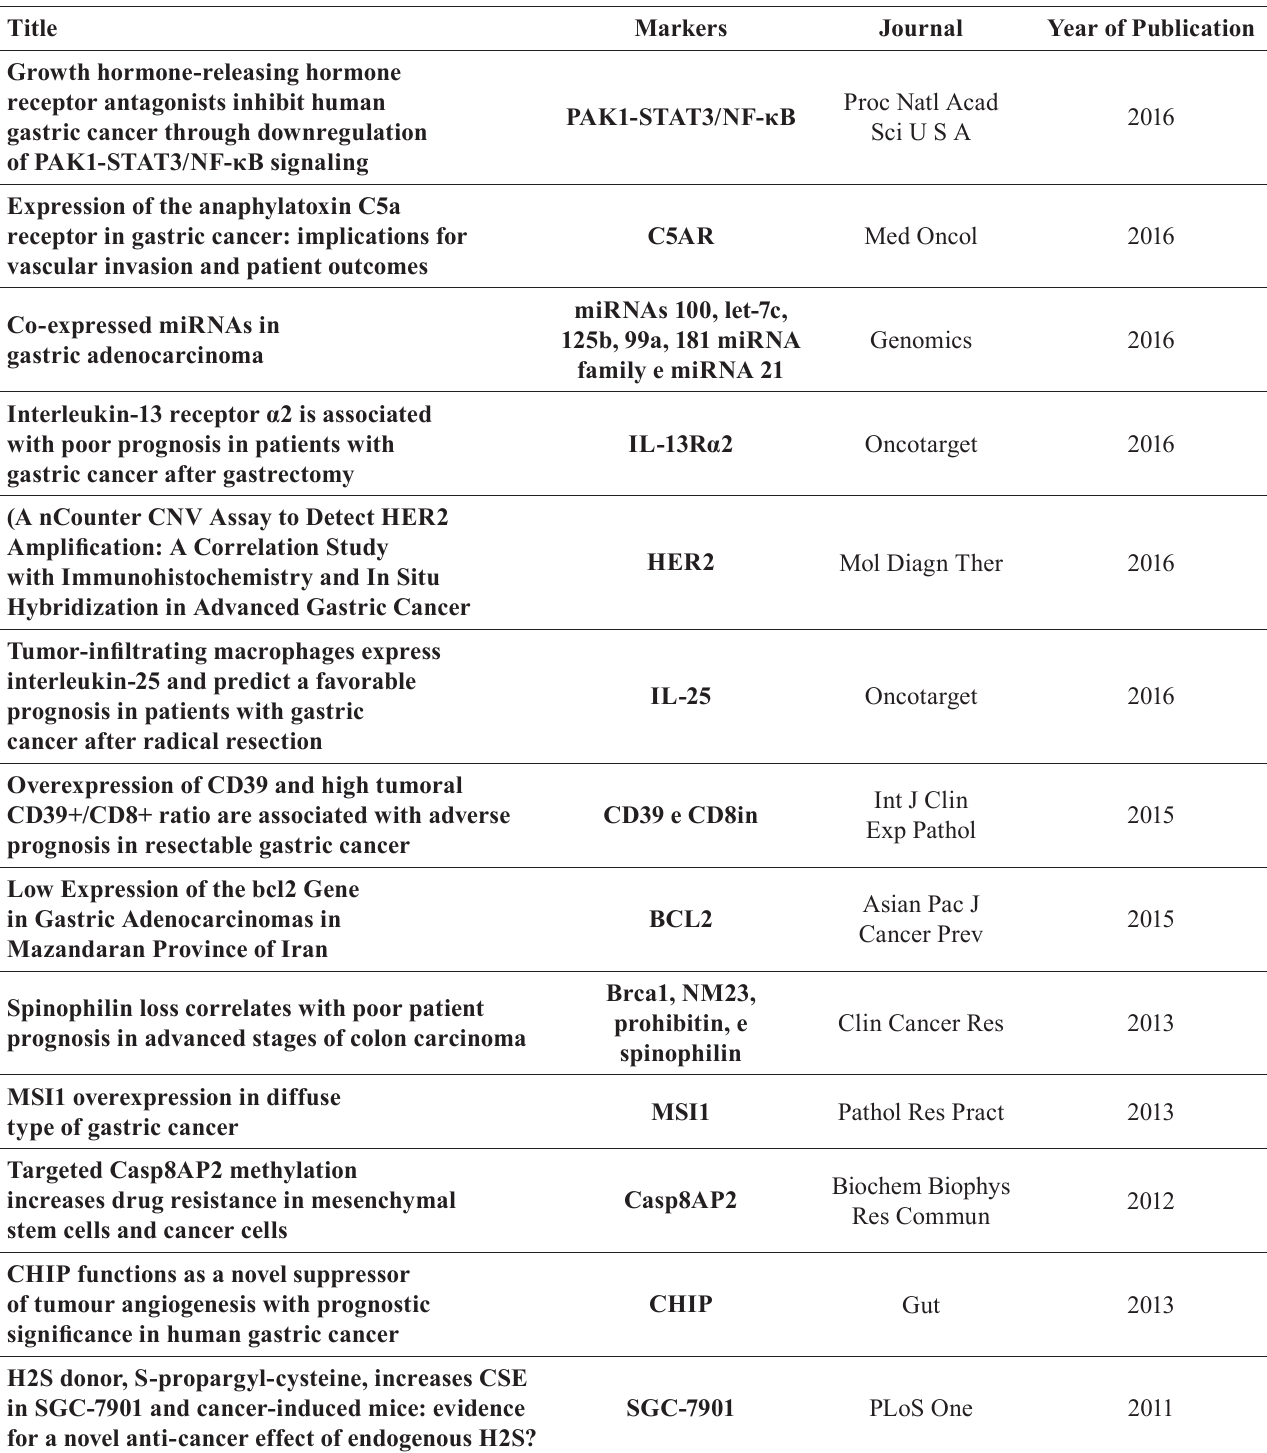
TABLE I - T umor targets of CRC identified in articles searched in PubMed, with their respective journals and year of publication